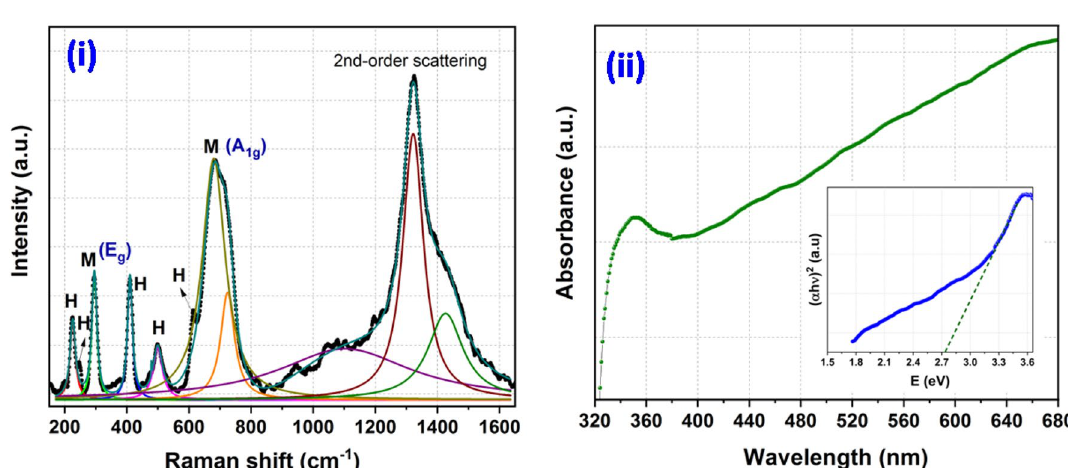
Figure 2. Raman spectrum of Fe 3 O 4 /α-F 2 O 3 nanocomposite ( i ) UV–Vis spectrum of Fe 3 O 4 /α-F 2 O 3 nanocomposite [inset shows Tauc plot to determine the optical band gap] ( ii